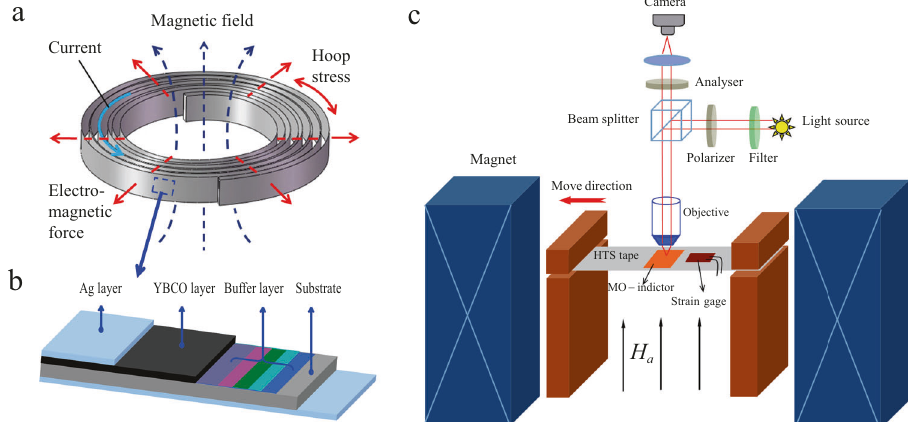
Fig. 1 Schematic of high-temperature superconducting magnet, second generation high-temperature superconducting tape and testing device. a Schematic of a pan-cake coil constructed by the coated conductors, the electromagnetic force in the radial direction causes a hoop tensile stress along the tape length. b The sample has a multi-layer structure, consisting of a Hastelloy-C276 substrate of with a thickness of 50 μ m, a buffer layer of 1 μ m, YBa 2 Cu 3 O 7 − δ (YBCO) layer of 1 μ m, and Ag layer of 2 μ m on both sides of the tape. c Schematic of the testing system, including a magneto-optical (MO) imaging microscope and cryogenic tensile loading